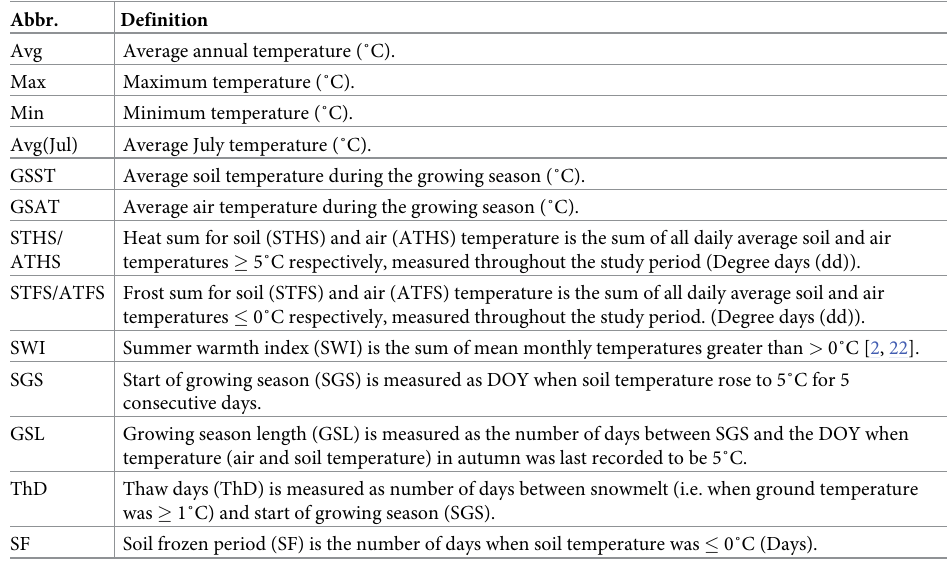
soil temperatures and will be followed by (A) and (S) respectively in further